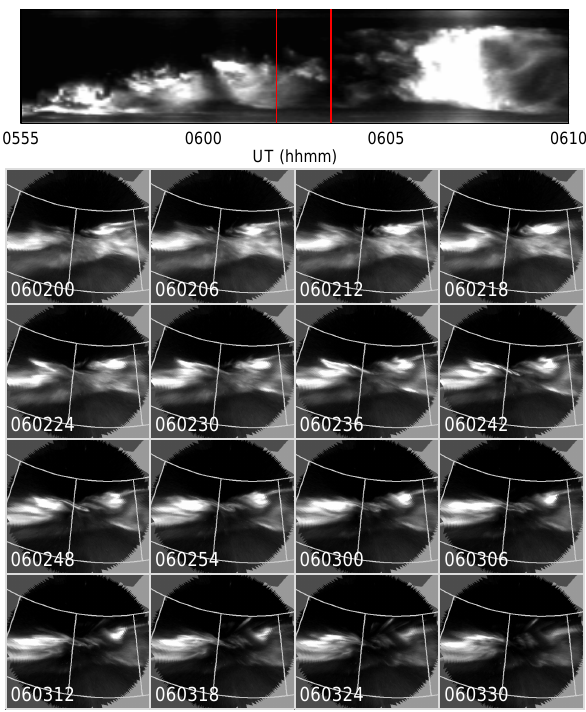
Fig. 8. Rankin Inlet all-sky images for the period 06:02:00– 06:03:30UT and a keogram for the period 05:55–06:10UT. The contours in the images are invariant latitudes (70 and 75 ◦ ), and in- variant longitudes separated by 15 ◦ or one hour of MLT. The two vertical red lines in the keogram mark the times of the first and last